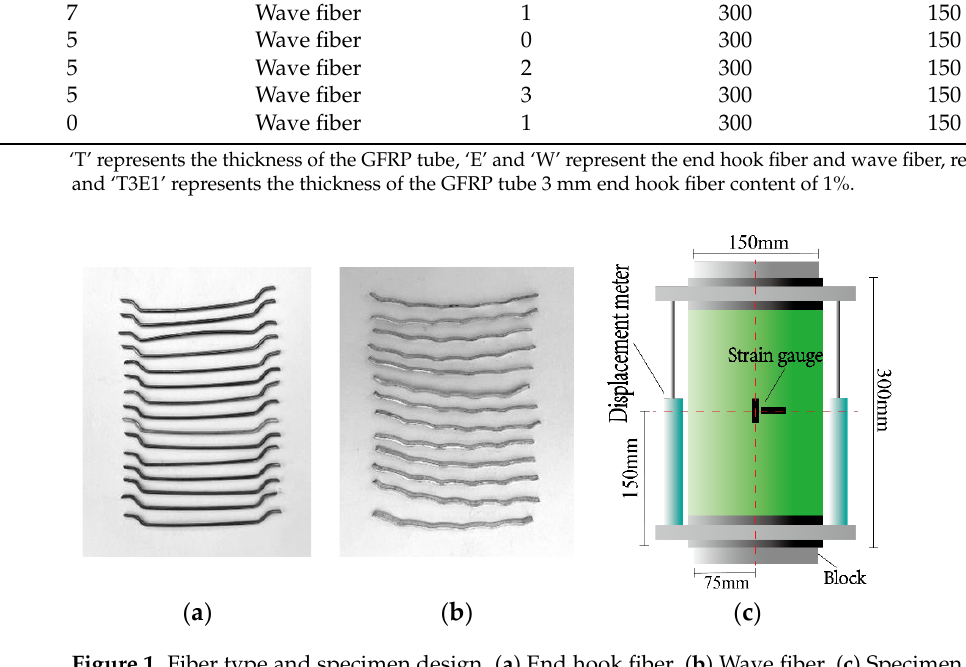
Figure 1. Fiber type and specimen design. ( a ) End hook fiber. ( b ) Wave fiber. ( c ) Specimen